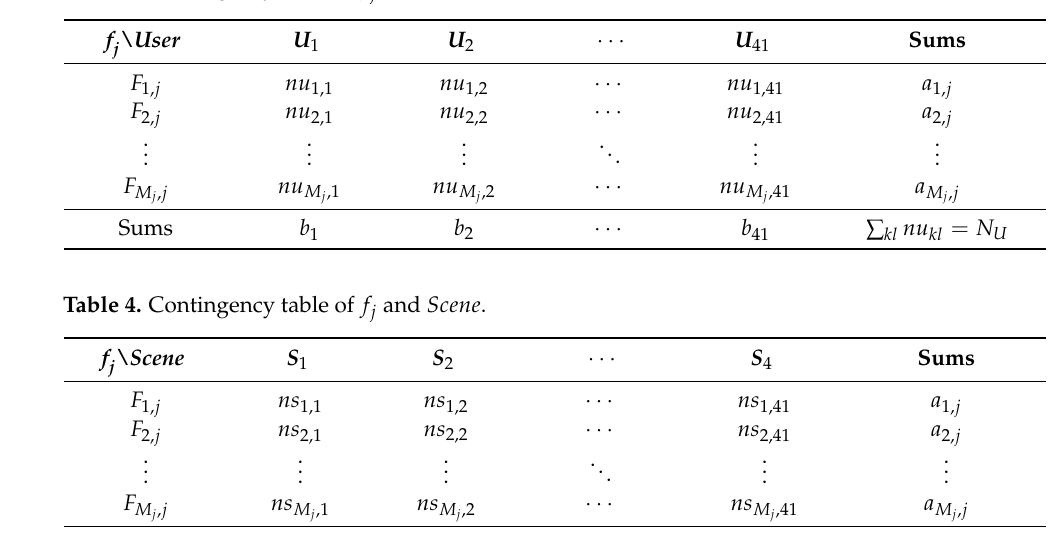
Table 3. Contingency table of f j and User .